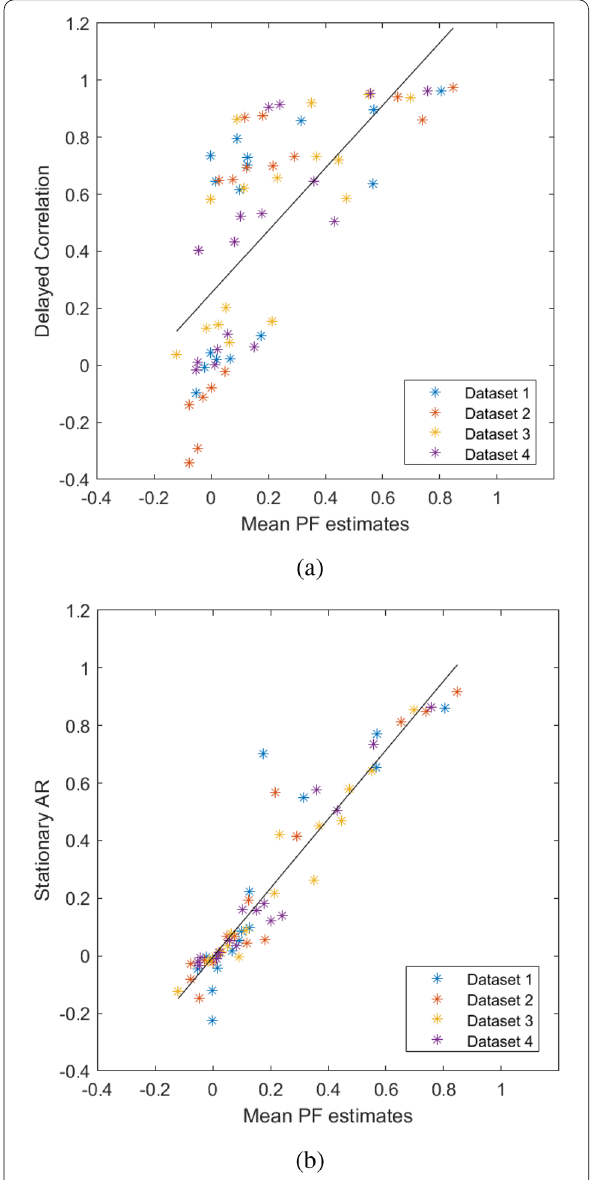
Fig. 8 a Scatter plot between mean PF estimates (horizontal axis) and delayed correlation (vertical axis) on the four visual experiments fMRI data. A p < 0.001 was obtained with a Pearson’s correlation coefficient ρ = 0.70 . The black line is the result of a linear fit. Slope and offset of the linear fit were 1.10 and 0.25 respectively. b Scatter plot between average PF estimates (horizontal axis) and stationary AR coefficients (vertical axis). The resulting Pearson’s correlation coefficient ρ was 0.94, with a p < 0.001 . The black line is the result of a linear fit, with slope and offset 1.2 and − 0.004 respectively